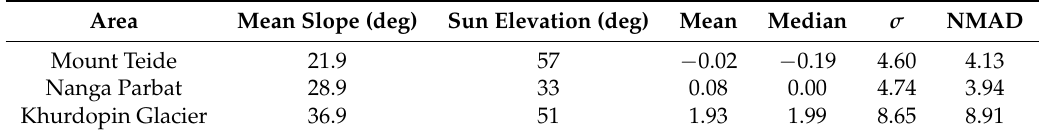
Figure 18. Elevation Differences over Khurdopin Glacier and the histogram of the elevation differences over stable terrain (Blue Outline). Table 1. Summary of the area wise statistics of the elevation differences in meters (m). These statistics are calculated only for the stable terrain, as shown in the histograms above. σ is the standard deviation. The approximate Sun elevation angle at the time of the image acquisitions for each test area are given in the 3rd